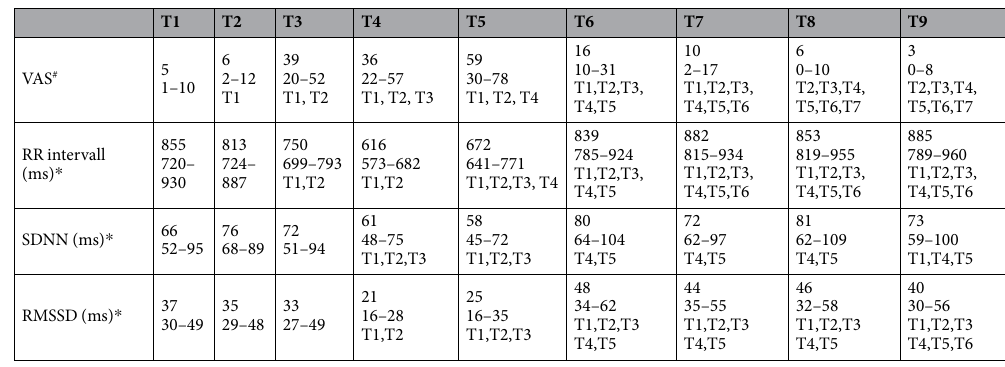
Table 2. Results of visual analogue scale and heart rate/heart rate variability. Median and IQR of parameters assessed at 9 times. # p Skillings-Mack < 0.001. * p Friedman < 0.001. The first row lists median, the second row lists the 25%- and 75%- percentile (IQR). The lowermost row of each parameter lists significant differences to other time points (p <